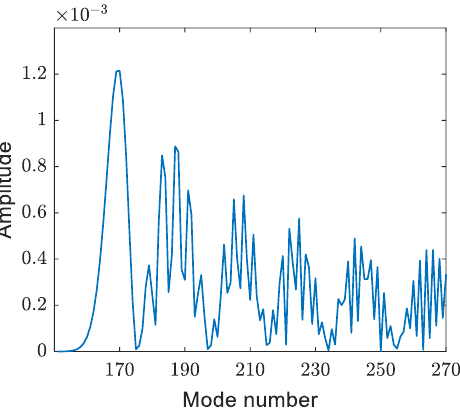
Figure 14. Mode amplitudes for refracted and surface-reflected modes obtained from experimental data.